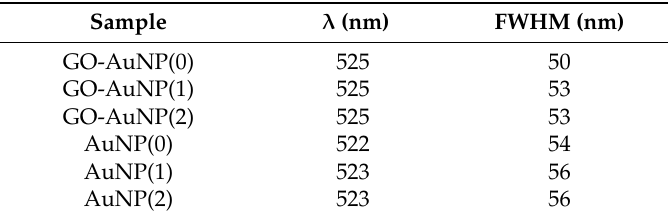
Table 1. Optical parameters from UV-vis spectra of hybrid GO-AuNP composites and AuNPs before (‘0’) and after the centrifugation for pellet 1 (‘1’) and pellet 2 (‘2’).